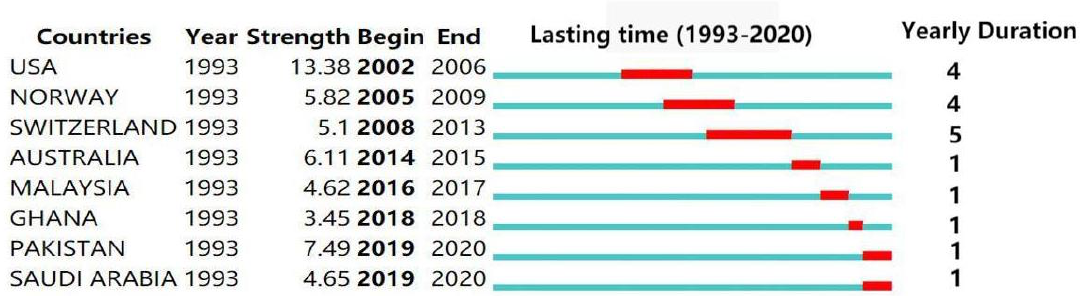
Figure 5. Annual trends in publications from top 10 countries.